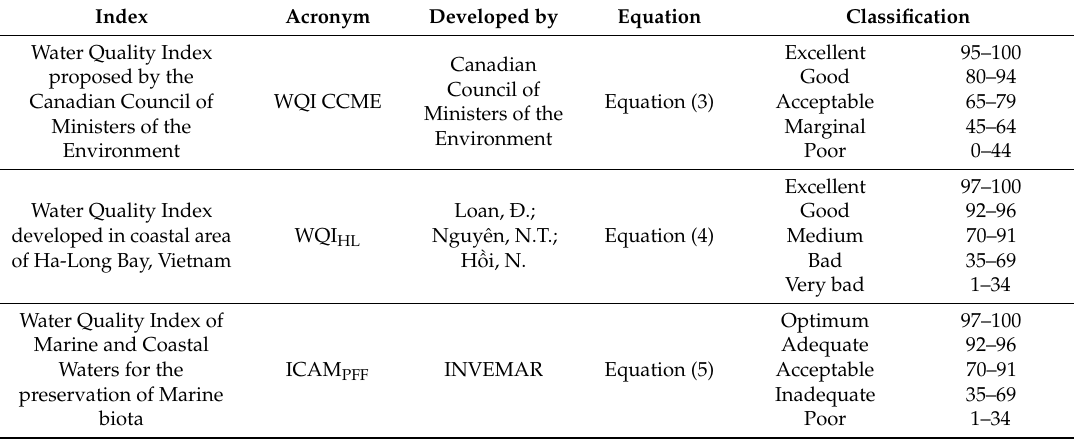
Table 4. Water quality